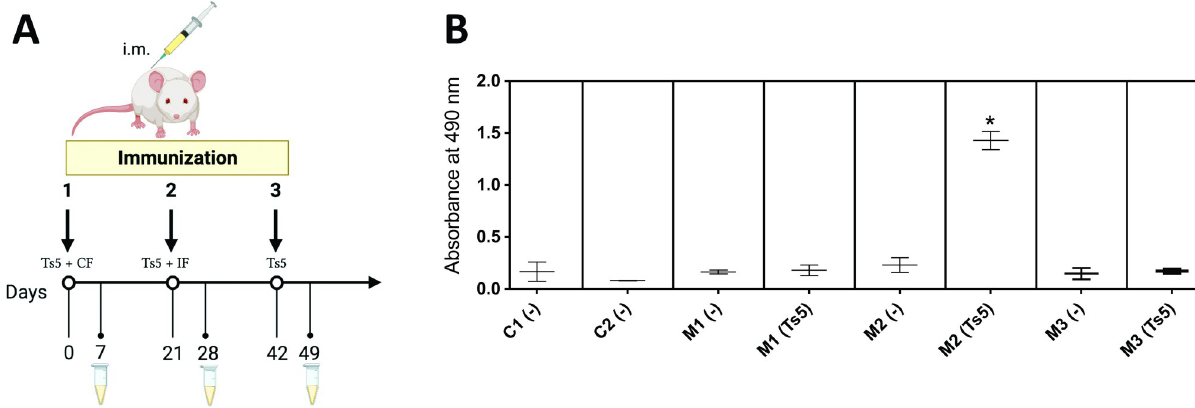
Fig 2. Ts5-immunization assay. (A) Male BALB/c mice (n = 3) received intramuscularly (i.m.) 7.5 μ g of Ts5 antigen emulsified in a solution containing complete Freunds’ adjuvant (CF), followed by two sequential i.m. boosts with 3-week intervals of 7.5 μ g and 5 μ g/animal, respectively. The second boost with Ts5 was diluted in a solution with incomplete Freunds’ adjuvant (IF), and the third boost consisted only by the antigen (Ts5). Control animals (n = 2) received solely saline solution (vehicle). Figure was created with BioRender.com (Agreement number: BO23GVKOCK). (B) Immunorecognition of Ts5 toxin (2 μ g/well) by animal’s sera used in experimental immunization. C (-): mice sera without immunization; M1(-): Mouse 1 serum before immunization; M1: Mouse 1 immunized with Ts5; M2 (-): Mouse 2 serum before immunization; M2: Mouse 2 immunized with Ts5; M3(-): Mouse 3 serum before immunization; M3: Mouse 3 immunized with Ts5. The ELISA assay was performed in duplicate, and results are plotted as mean ± SD. Data was analyzed using one-way ANOVA and Tukey’s post hoc test. Graph was generated using GraphPad Prism Version 9.3.1. � p < 0.05, when compared to negative controls.